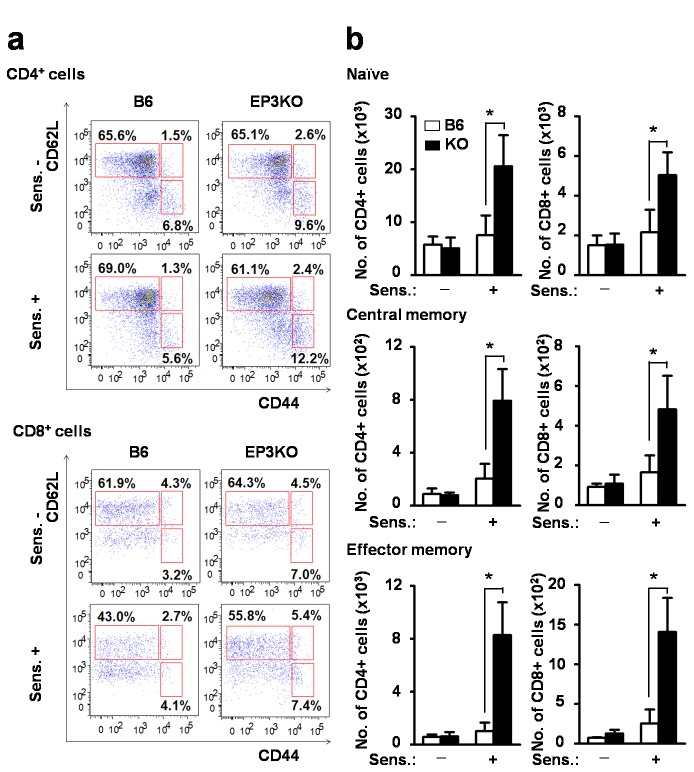
Increased the number of T cell subsets in draining lymph nodes in EP3KO mice.Draining lymph nodes were collected the mice of 5 days after the DNFB or vehicle application mice. (a) Representative flow cytometric plots. (b) The numbers of CD44- CD62L+ naïve (upper panel), CD44+CD62L+ central memory (middle panel), and CD44+CD62L- effector memory (lower panel) subsets of CD4+ T cells (left panels) and CD8+ T cells (right panels) of B6 and EP3KO mice were counted and indicated by white and black bars, respectively (n=6). Each data represents the mean + SD. *p<0.05.